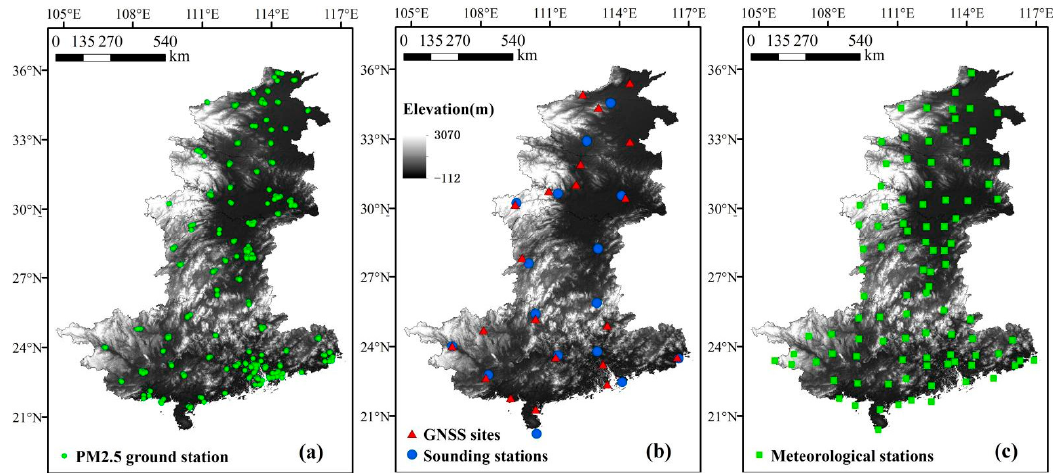
Figure 1. Distribution of observation stations. GNSS: global navigation satellite system. ( a ) PM 2.5 ground station, ( b ) GNSS sites and Sounding stations, ( c ) Meteorological stations. GNSS (global navigation satellite system)-derived data (PWV and ZTD) were col- lected from 16 sounding stations and 21 GNSS sites in south-central China for annual av- erage values from 2017 to 2019 and quarterly average values from December 2016 to No- vember 2019, respectively (Figure 1b). (PWV from http://weather.uwyo.edu/up- perair/sounding.html, accessed on 31 March 2021; ZTD from http://www.cgps.ac.cn/, ac-